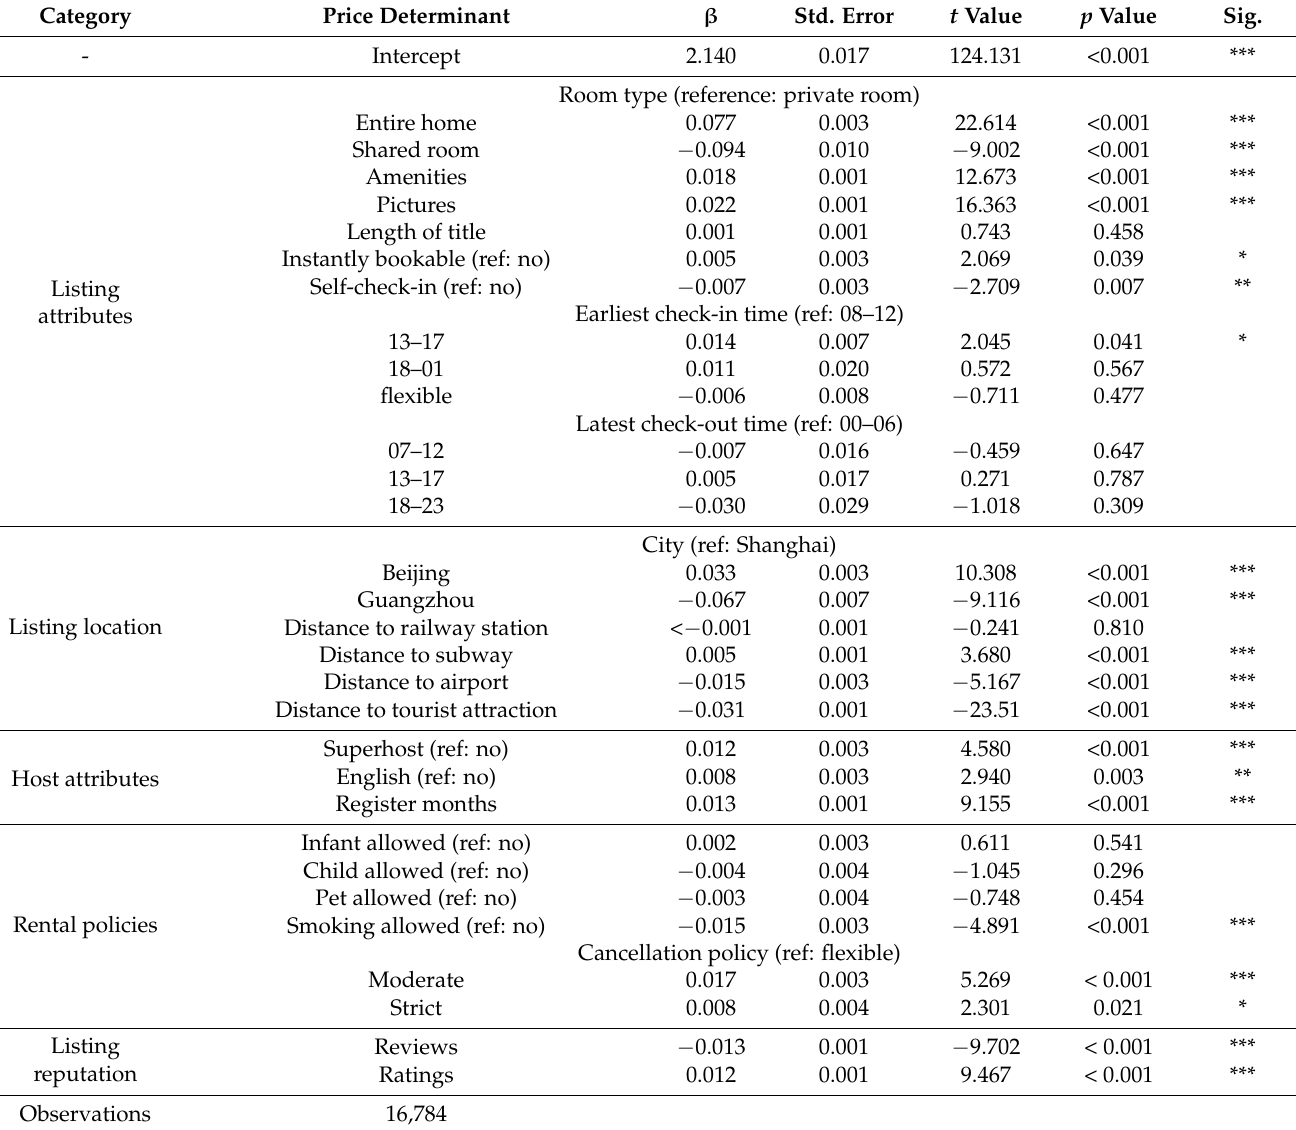
Table 4. Regression results from Model